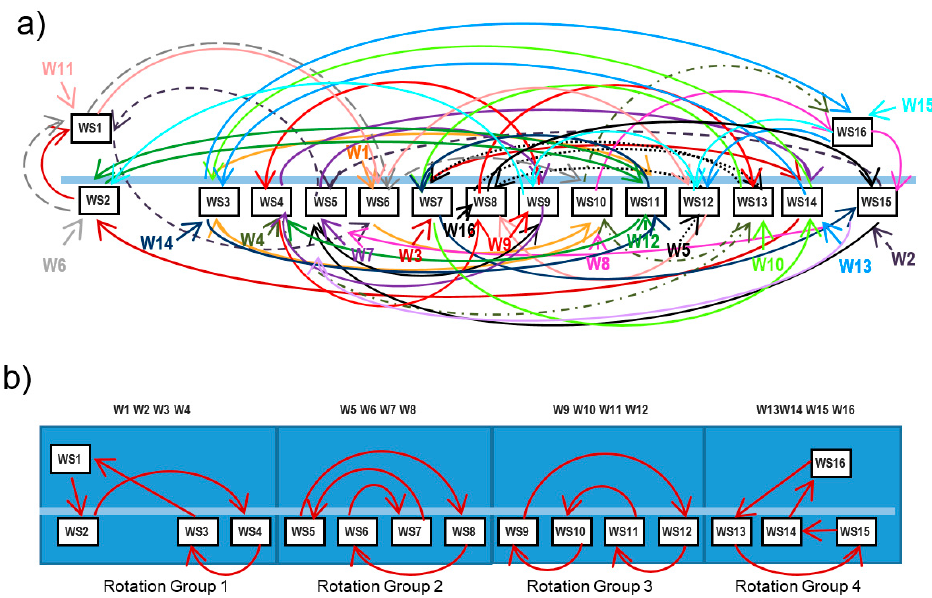
Figure 1. Example of a job rotation schedule with four rotations. ( a ) 16 workers rotate in 16 workstations. ( b ) Four workers rotate in four rotation groups with four workstations each one. To face these problems, this work proposes a different approach to create job rotation schedules.